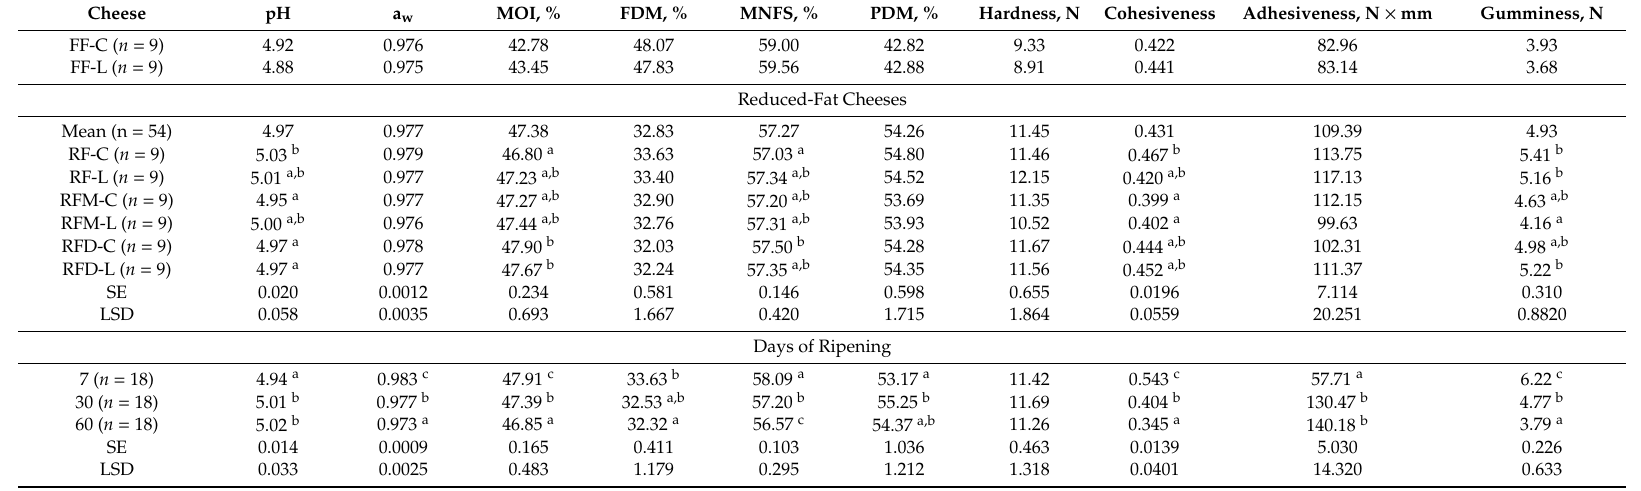
Table 3. Compositional and textural characteristics of reduced-fat sheep milk cheeses. Cheese codes are according to Tables 1 and 2. SE: standard error; LSD: least significant di ff erence; MOI: moisture; FDM: fat on dry matter; MNFS: moisture on non-fat substances; PDM: protein on dry matter; C: classic NaCl brine; L: “light” NaCl / KCl 1:1 brine.